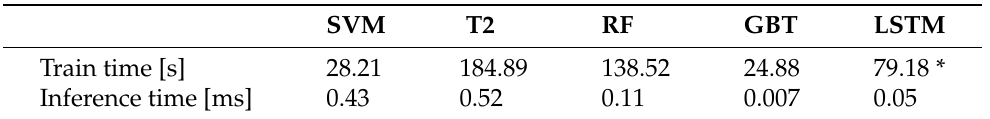
Table 4. Train and inference time information for the different models. (* LSTM was trained on a GPU to speed up